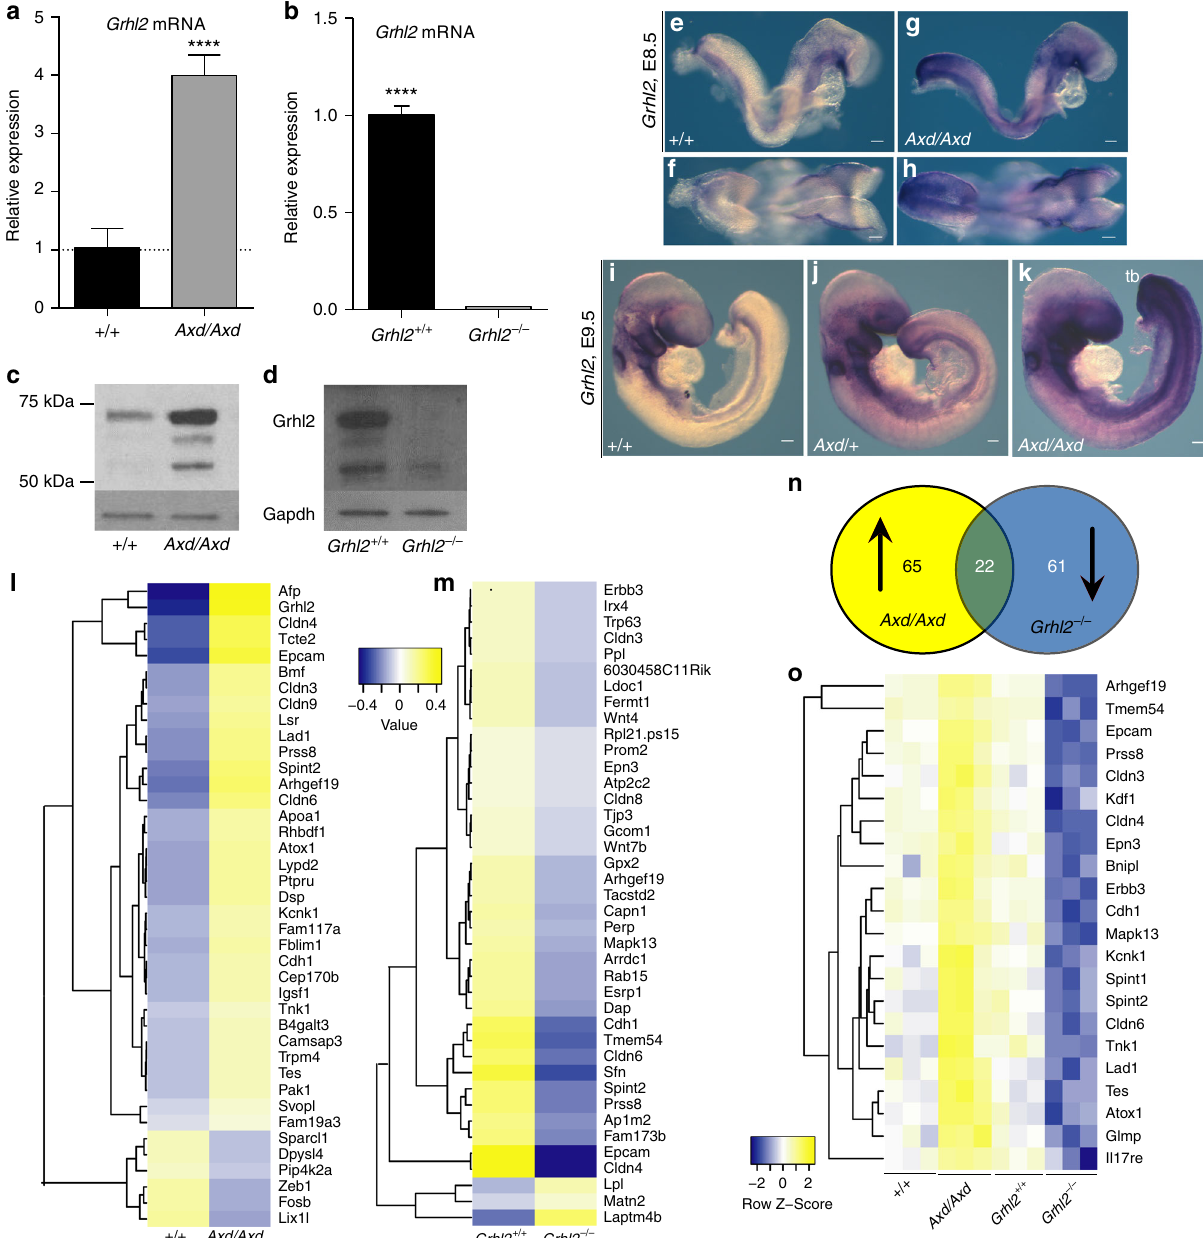
Cldn4EpcamFam173bAp1m2Prss8Spint2SfnCldn6Tmem54Cdh1DapEsrp1Rab15Arrdc1Mapk13PerpCapn1Tacstd2Arhgef19Gpx2Wnt7bGcom1Tjp3Cldn8Atp2c2Epn3Prom2Rpl21.ps15Wnt4Fermt1Ldoc16030458C11RikPplCldn3Trp63Irx4Erbb3 Fig. 2 Transcriptomic effect of Grhl2 loss and over-expression. Abundance of a , b Grhl2 mRNA and c , d Grhl2 protein is signi fi cantly elevated in the caudal region of a , c Axd/Axd embryos and diminished in b , d Grhl2 − / − embryos at E9.5 (17 – 19 somite stage); **** p < 0.0001; t -test; mRNA data represents mean ± SEM ( n = 6 samples/genotype). Example immunoblot in d is exposed to show all + / + bands. e – k Increased expression of Grhl2 in Axd/Axd embryos at E8.5 ( e , f ; dorsal view in f and h ) and E9.5 ( i – k ; examples at 16 somite stage). Apparent upregulation or ectopic expression is detected in the tail bud (tb; i – k ) in Axd/Axd embryos. Scale bars represent 100 μ m. Images are representative of a minimum of three embryos per genotype. l – o Heat maps of the 40 most signi fi cant differentially expressed genes in RNA-Seq analysis of the caudal region of l Axd/Axd or m Grhl2 − / − embryos and their wild-type littermates at E9.5. Boxes represent mean of triplicate samples. Grhl2 over-expression predominantly causes upregulation (yellow shading in l ), whereas loss of Grhl2 causes downregulation (blue shading in m ). n Among genes upregulated in Axd/Axd and downregulated in Grh2 − / − , 22 were common. o Heat-map of the expression pro fi le of the 22 common genes. Boxes represent individual samples. Source data are provided as a Source Data fi Grhl2 regulates the composition of apical junction complexes . apparent in wild-type embryos and even more notable in Axd/ Whole-mount in situ hybridisation con fi rmed expression of Axd littermates (Fig. 3l, r). Immunostaining for E-cadherin and Cdh1 , Cldn4 and EpCAM in the surface ectoderm in the spinal Cldn4 in the surface ectoderm is consistent with in situ hybri- region (Fig. 3g – x and Supplementary Fig. 4). Cdh1 and Cldn4 disation data and particularly evident in the midline surface mRNA is especially abundant in the surface ectoderm overlying ectoderm, immediately rostral to the closure point (Fig. 3y – d'). the neuroepithelium of the neural folds and the midline of the Cldn4 is localised as expected at cell borders, with prominent immediately closed neural tube (Fig. 3g – r). This enrichment is staining at the neuroepithelium/surface ectoderm border of the